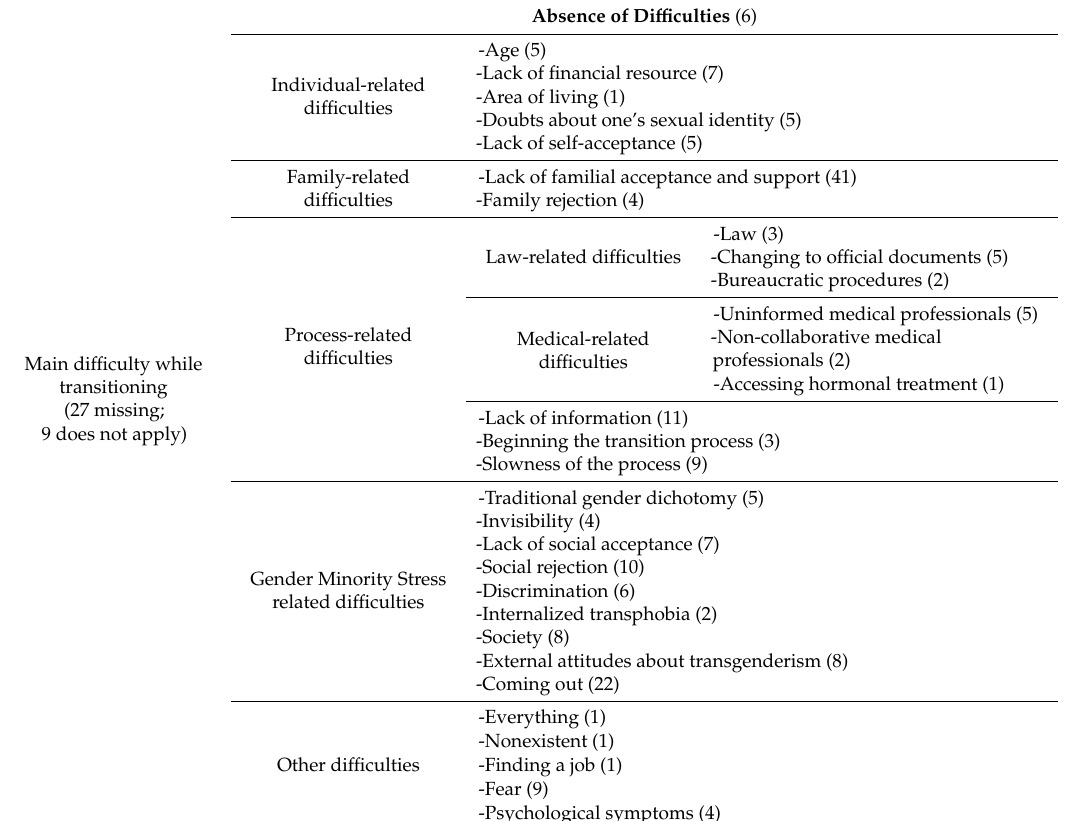
Table 2. Main themes and respective codes regarding the question “In your own words, what was your main di ffi culty when you were